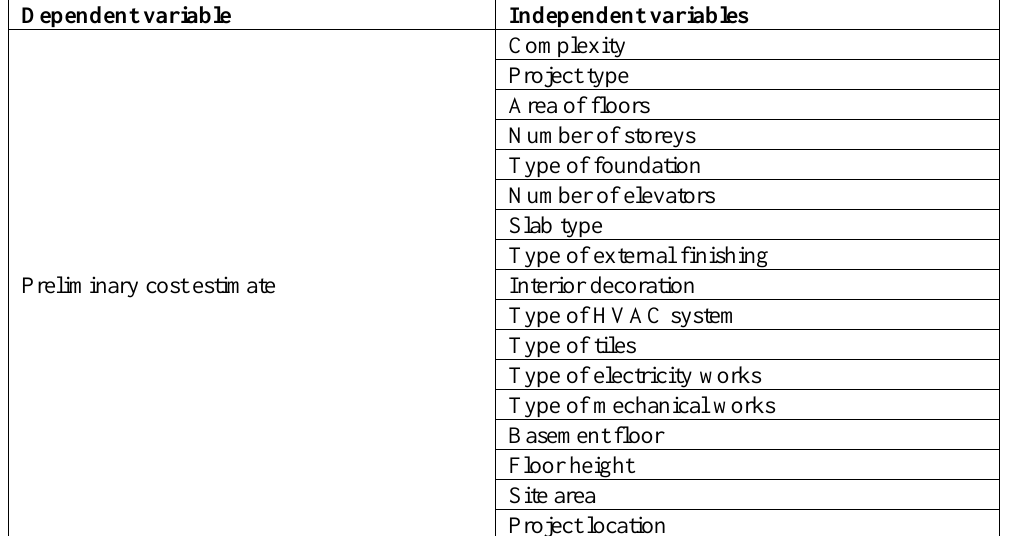
Table 1. The selected dependent and independent variables (developed by the